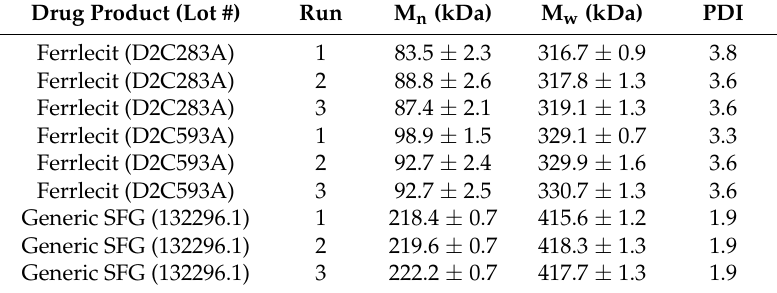
Table 7. Asymmetric field flow fractionation-multi-angle light scattering (AFFF-MALS) results